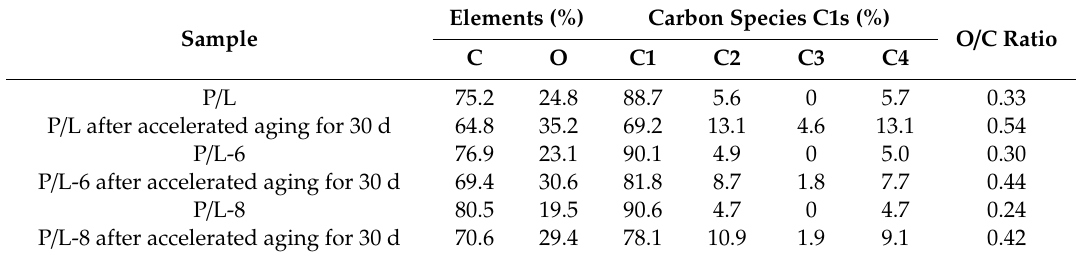
Table 3. Surface chemistry components of SLS parts as determined by XPS.